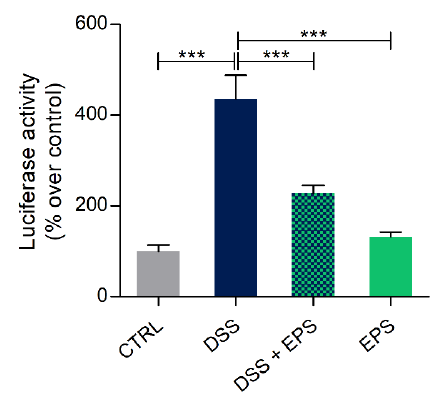
Figure 6. Anti-inflammatory effects of Phormidium EPS after dextran sulfate sodium (DSS) induced inflammation in zebrafish larvae. Recovery from inflammation was analyzed with the zebrafish transgenic line NFκB:GFP,Luc. The data represent the mean ± SEM of three independent experiments conducted with 12–15 larvae. Statistical analysis was performed using GraphPad Prism 7 (one-way ANOVA followed by Tukey’s multiple comparison test). Statistical significance: * p ≤ 0.05, *** p ≤ 0.001.